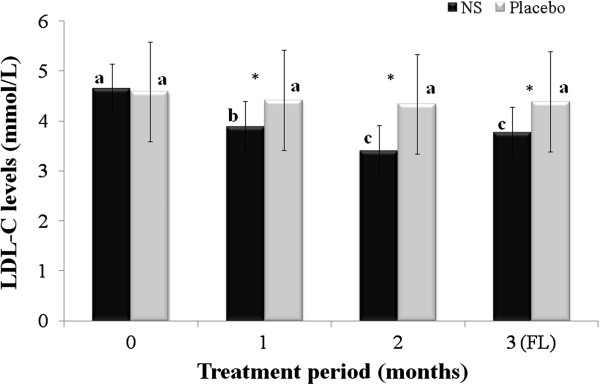
Changes in serum low density lipoprotein (LDL); menopausal women randomly assigned to Nigella sativa (N.S) or placebo groups were treated for 2 months and blood samples taken at baseline, and 1 and 2 months after the start of the intervention, and one month after cessation of intervention (FL), and used to evaluate serum LDL. Results are expressed as mean ± SD. *significant between N. S vs. placebo group at p < 0.05. Different letters on bars representing different intervals for the same group indicate significant difference between the intervals for the same treatment (p < 0.05).